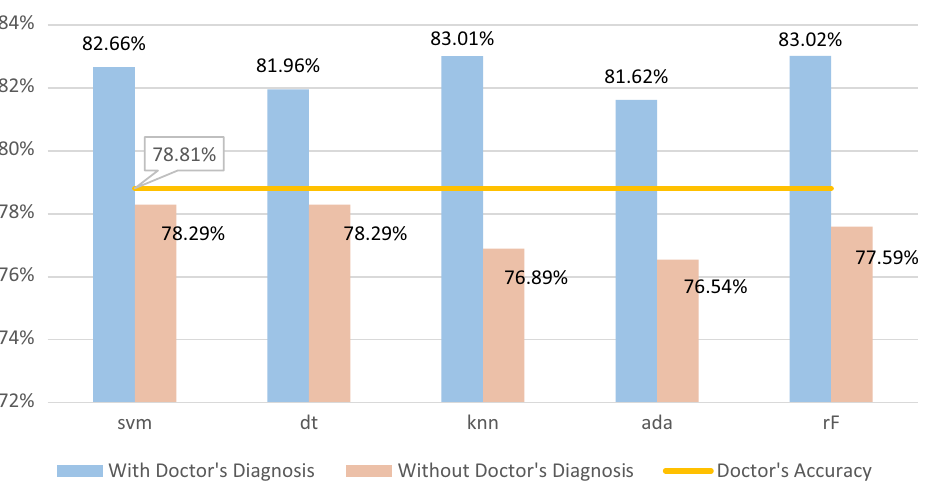
Figure 5. Best tenfold testing accuracies (%) achieved by each ML model when using expert’s verdict as input (blue) and when not (orange). The comparison horizontal line depicts the doctor’s accuracy